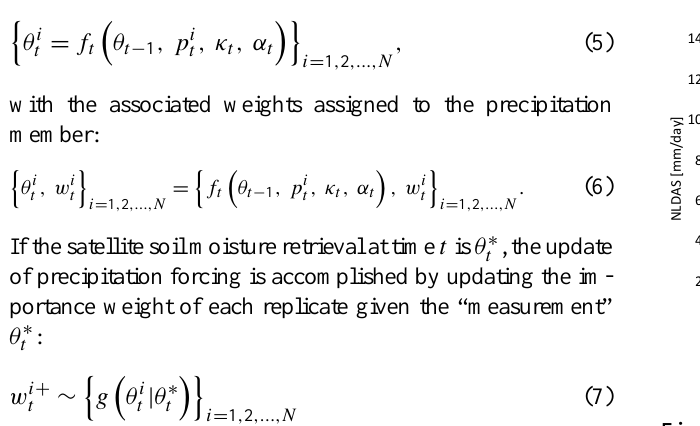
Figure 3. Statistics of NLDAS precipitation given 3B42RT precip- itation measurement. Boxplot shows the minimum, 15% quantile, 30% quantile, median, 70% quantile, 85% quantile and maximum value of NLDAS precipitation given 3B42RT precipitation in a cer- tain